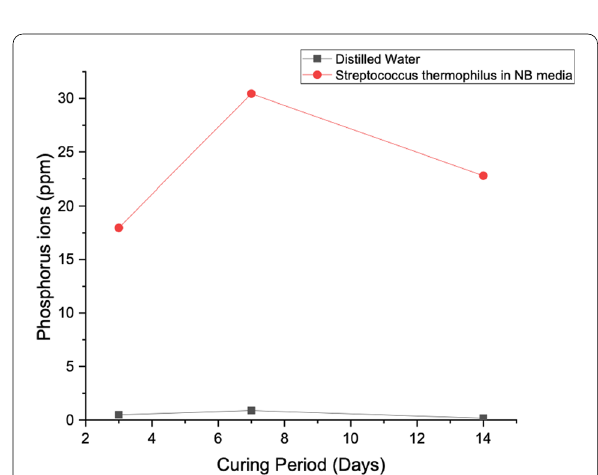
Fig. 6 Phosphorus ion concentration of distilled water (DW) and Streptococcus thermophilus bacteria in nutrient broth NB media at different curing